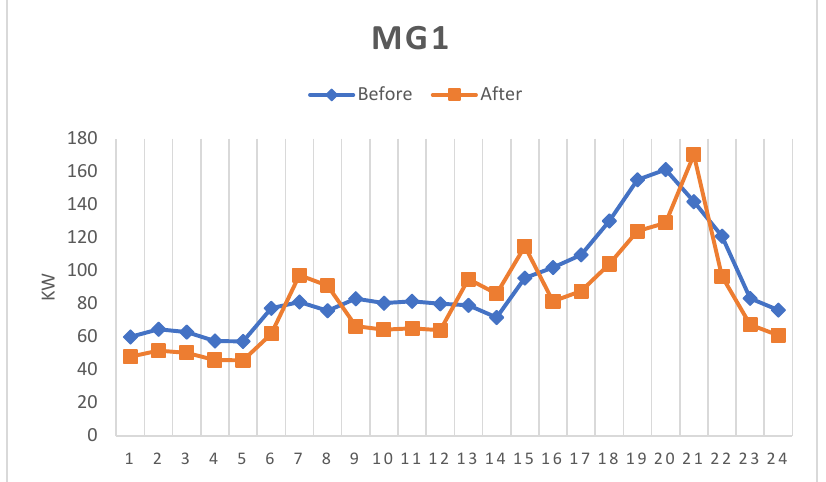
Figure 8. Consumption variations in microgrid 1: model 1.